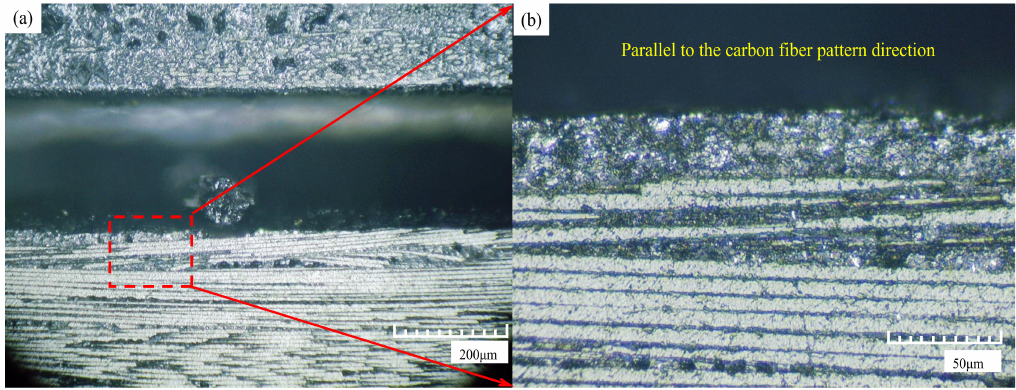
Figure 17. Parallel fiber direction processing end surface (( a ). the groove morphology at the fiber fracture; ( b ). partial enlargement of the